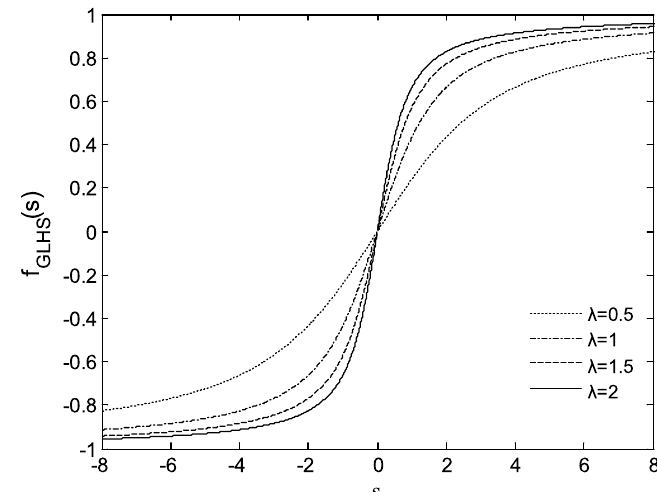
Fig. 1 The GLHS function curves with different scaling